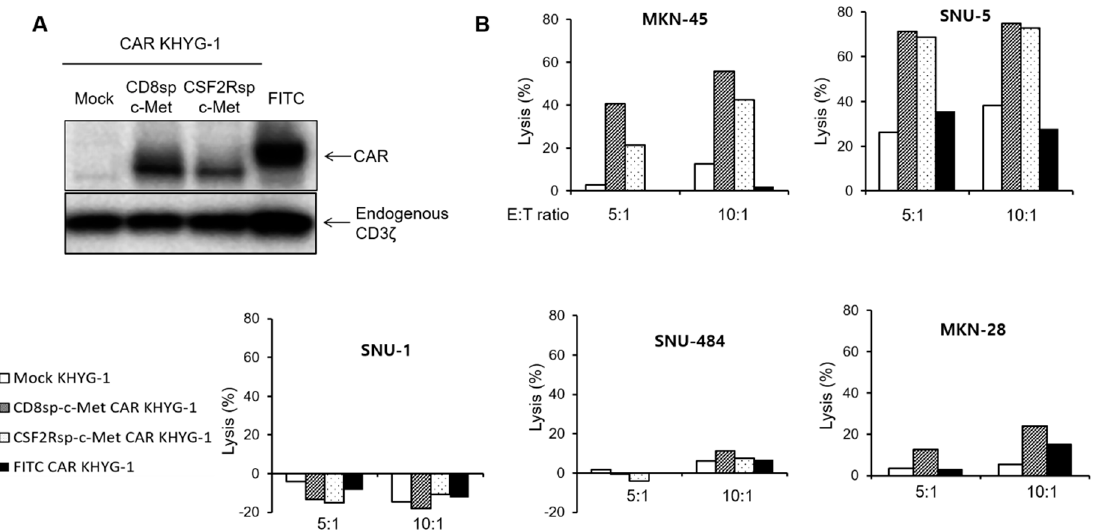
Figure 4. c-Met CAR KHYG-1 specifically lyses the c-Met positive GC cells. ( A ) Western blot with the cell lysates of mock CD8sp-c-Met, CSF2Rsp-c-Met, or FITC KHYG-1 cells to see the CAR expression ( B ) The mock CD8sp-c-Met CAR, CSF2Rsp-c-Met CAR, or FITC CAR KHYG-1 were co-incubated with MKN-45, SNU-5, SNU-1, and SNU-484 at E:T ratio of 5:1 or 10:1 for 5 h. The cytotoxicity of CAR KHYG-1 was measured by the Bright-Glo (luciferase) assay system. (The whole western blots figure see Figure S1).